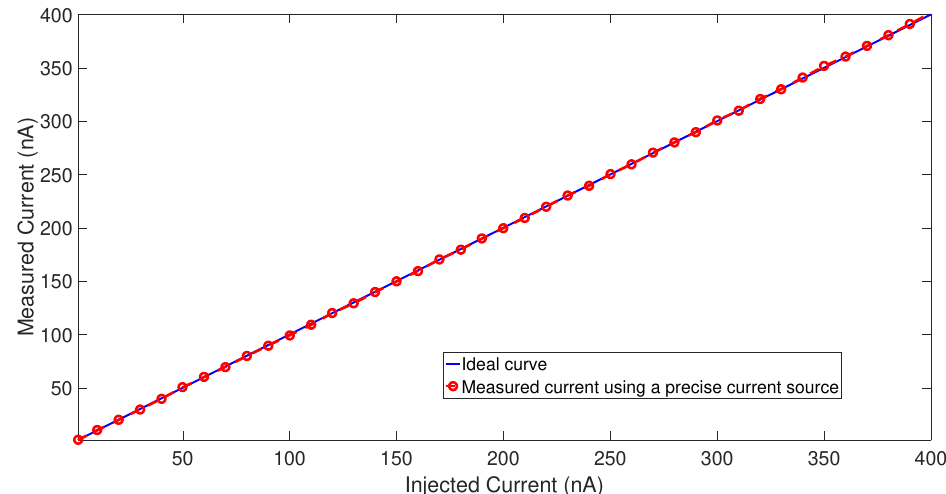
Figure 12. Linearity measurements from 1nA to 400nA using a precise laboratory current source from Keithley.